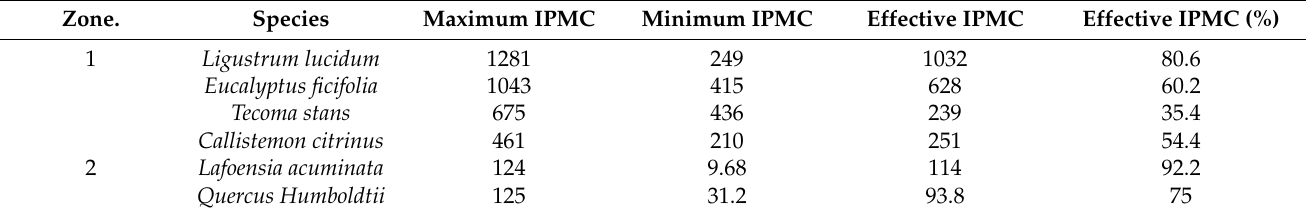
Table 1. Monthly average IPMCs for species under study (potential